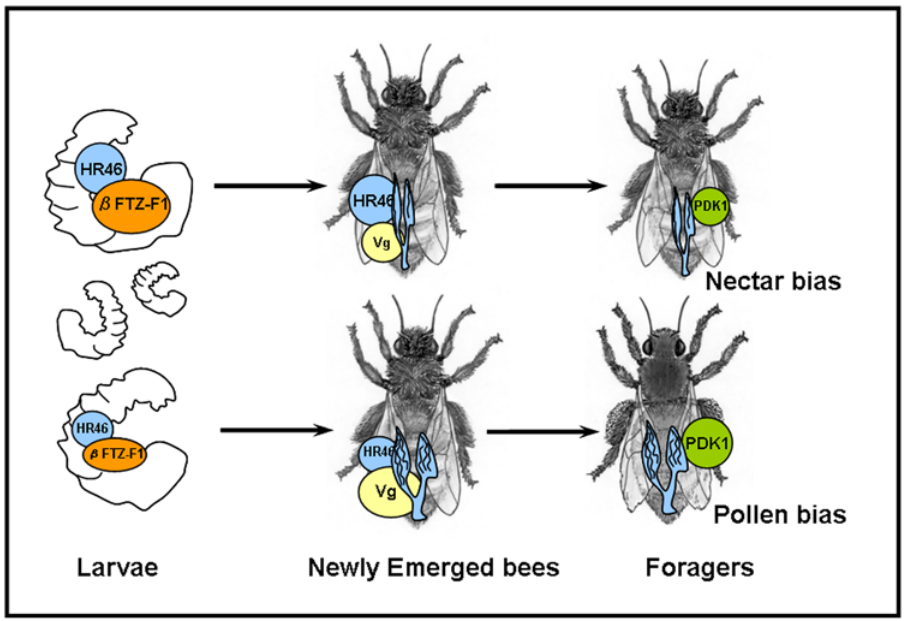
Figure 5. Genetic architecture of honey bee foraging behavior. HR46 and PDK1 can influence foraging behavioral decisions by acting during different life-stages and in different ways. As a putative affector of b FTZ- F1 activity, HR46 may be part of the apoptotic signaling system that determines worker ovary size. Bees with large ovaries tend to have higher levels of Vg mRNA as young adults. Vg is a key behavioral affector gene that influences foraging onset and foraging bias: increased levels are associated with a bias toward early foraging onset and pollen bias. In foragers, ovary size is linked to PDK1 gene activity, so that ovary size and PDK1 mRNA levels both are higher in workers with a foraging bias toward pollen. In short, we propose that HR46 acts in larvae to determine ovary size, which influences ovarian signaling in adult workers quantitatively and/or qualitatively, with effects on Vg , PDK1 /IIS and foraging behavior.